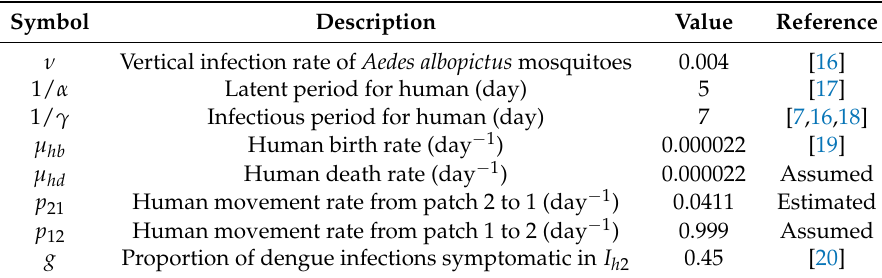
Table 1. Descriptions and values of